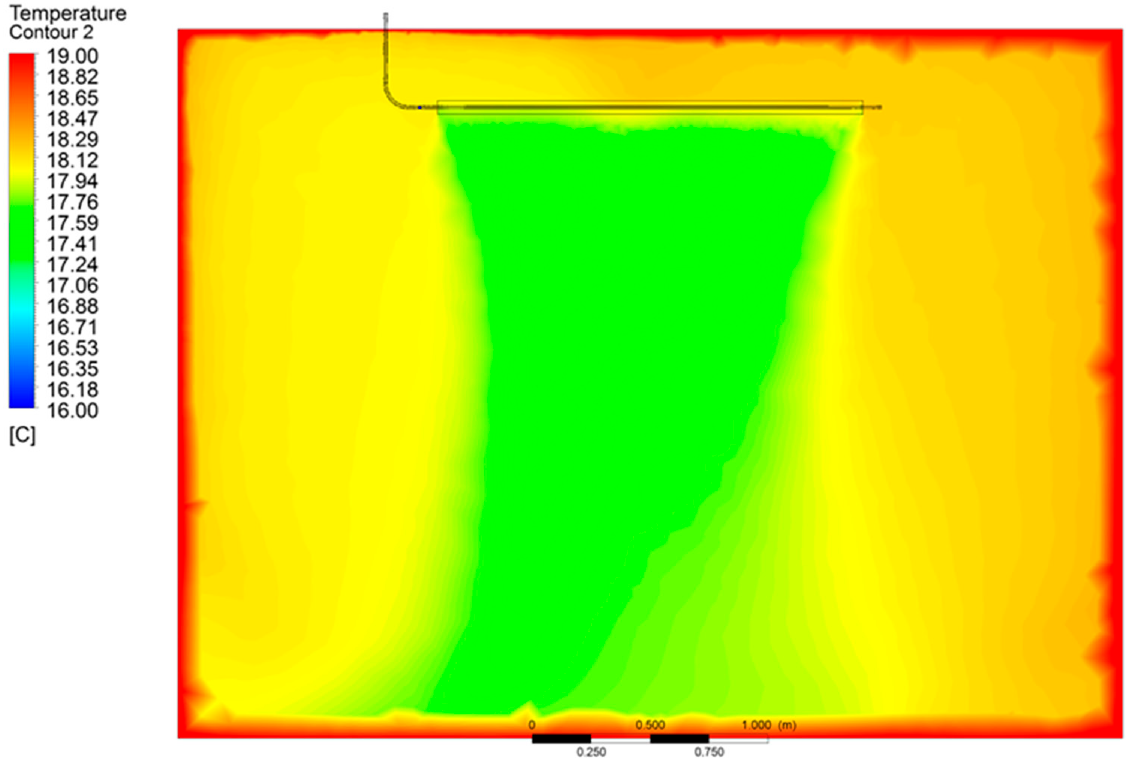
Figure 22. Model of passive cooling beam—the contours of temperature (°C).